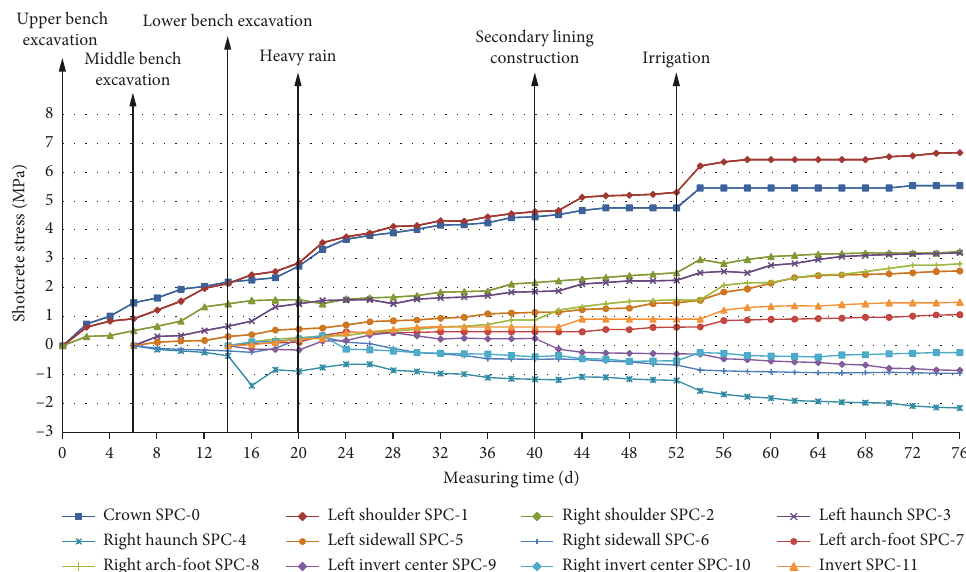
Figure 13: Monitoring results of shotcrete stress (Color figure